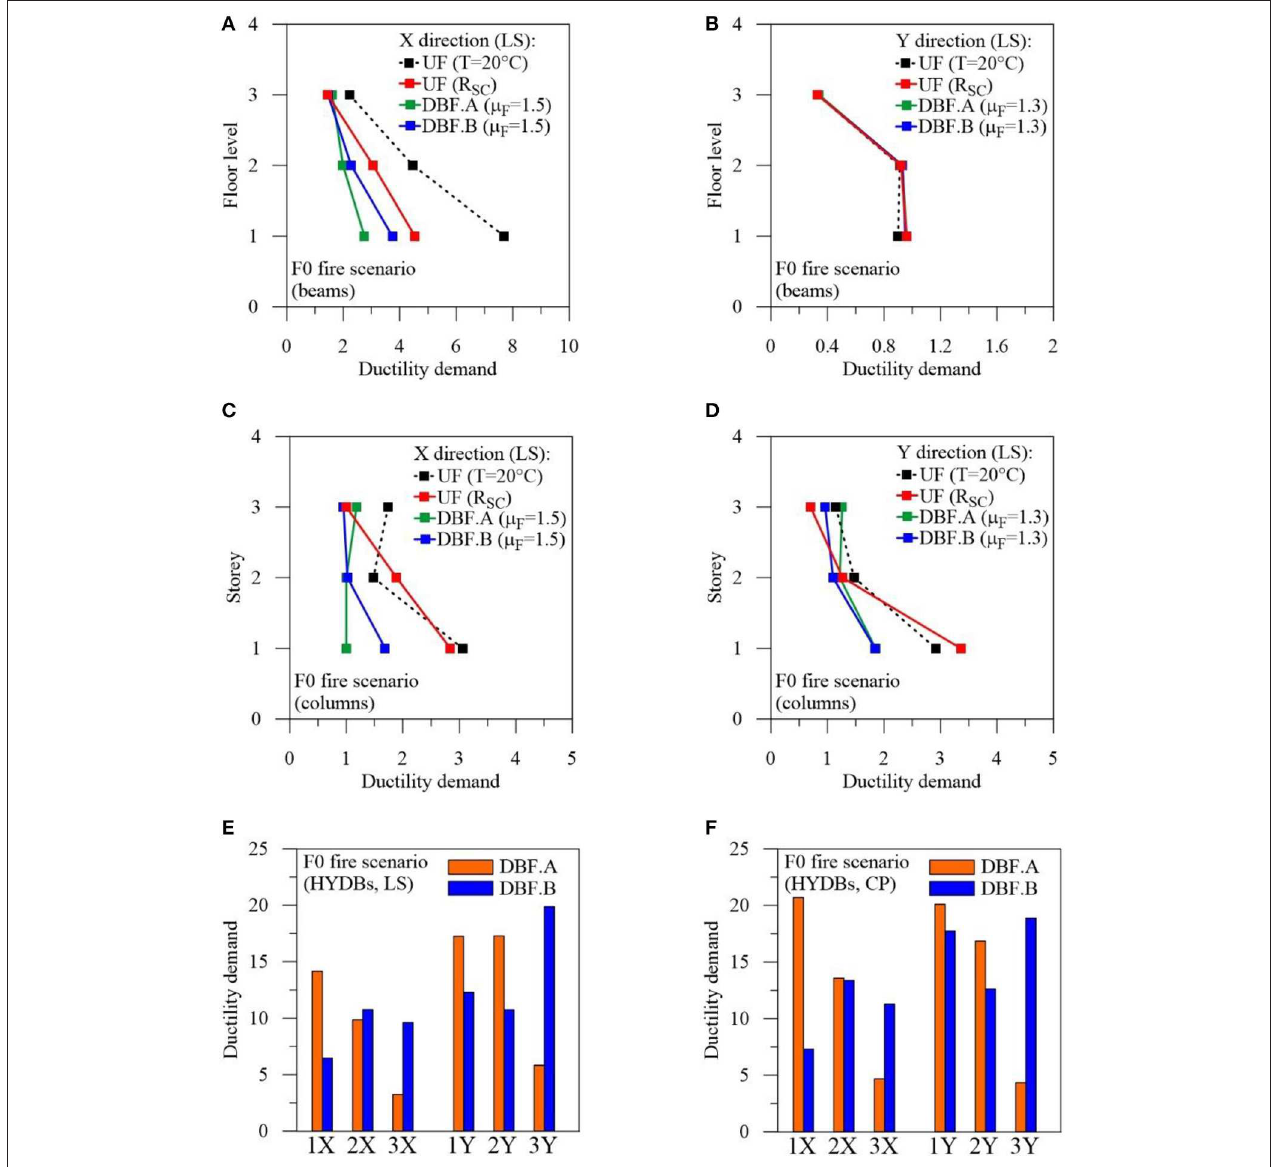
FIGURE 12 | Ductility demand of r.c. frame members and HYDBs for the Collina-Castello school. (A) Beams (X direction, LS). (B) Beams (Y direction, LS). (C) Columns (X direction, LS). (D) Columns (Y direction, LS). (E) HYDBs (X and Y directions, LS). (F) HYDBs (X and Y directions,